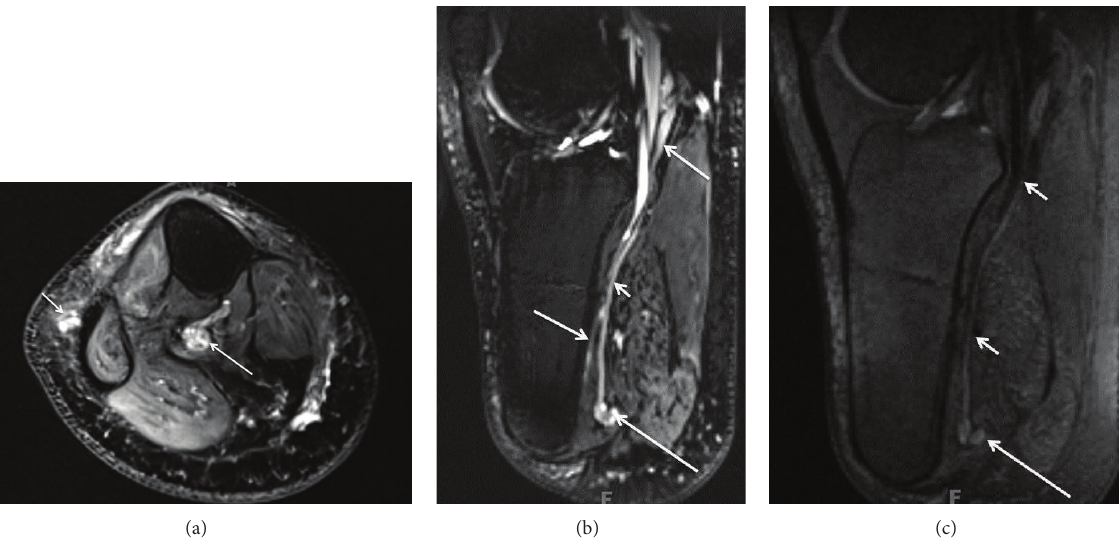
Figure 3: (a) Limitation of 3D anatomic nonselective MRN-Axial T2 SPAIR image through the upper calf shows amputation neuromas of tibial nerve (large arrow) and common peroneal nerve (small arrow). (b) Limitation of 3D anatomic nonselective MRN-Sagittal reconstruction from a 3D SPAIR SPACE sequence in the same case shows the abnormal tibial nerve in its long axis (smaller arrow) with an end-bulb neuroma (large arrow). However, there is suboptimal depiction due to hyperintense vascular signal contamination (medium arrows). (c) 3D anatomic nerve selective MRN-Sagittal reconstruction from a 3D DW PSIF sequence in the same case selectively shows the